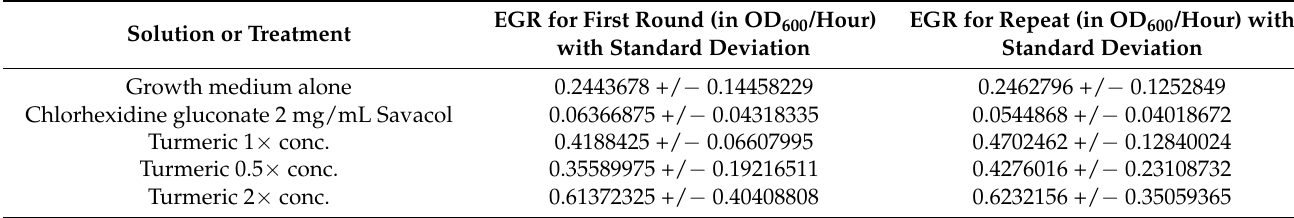
Table 3. Table displaying the calculated exponential growth rates of the oral bacteria for each treatment solution, in OD 600 /hour.